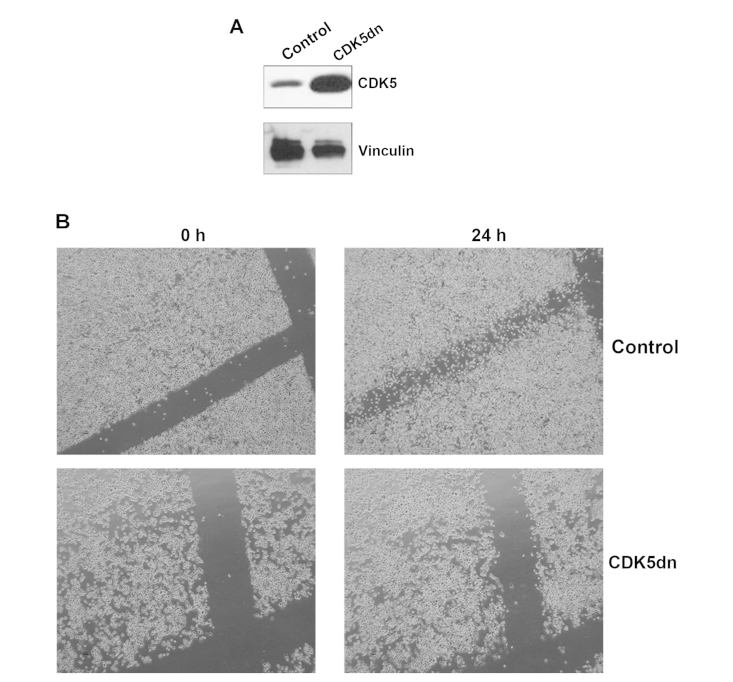
Suppression of CDK5 activity by transfection of a dominant-negative construct. (A) PC3 cells were transfected with a pBI-EGFP vector with or without a CDK5 dominant-negative construct; clones in which transfection was successful were selected. A western blotting for CDK5 was performed with these PC3 CDK5dn and control cell lysates. (B) Wound healing assay with PC3 CDK5dn and control cells to confirm CDK5 inactivity in PC3 CDK5dn cells. CDK5, cyclin-dependent kinase 5.